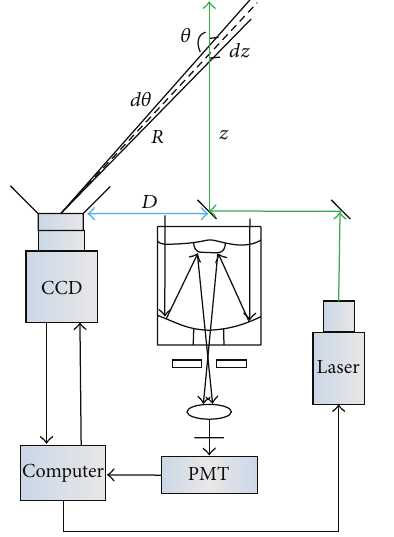
Figure 1: Configuration of the dual field of view lidar.